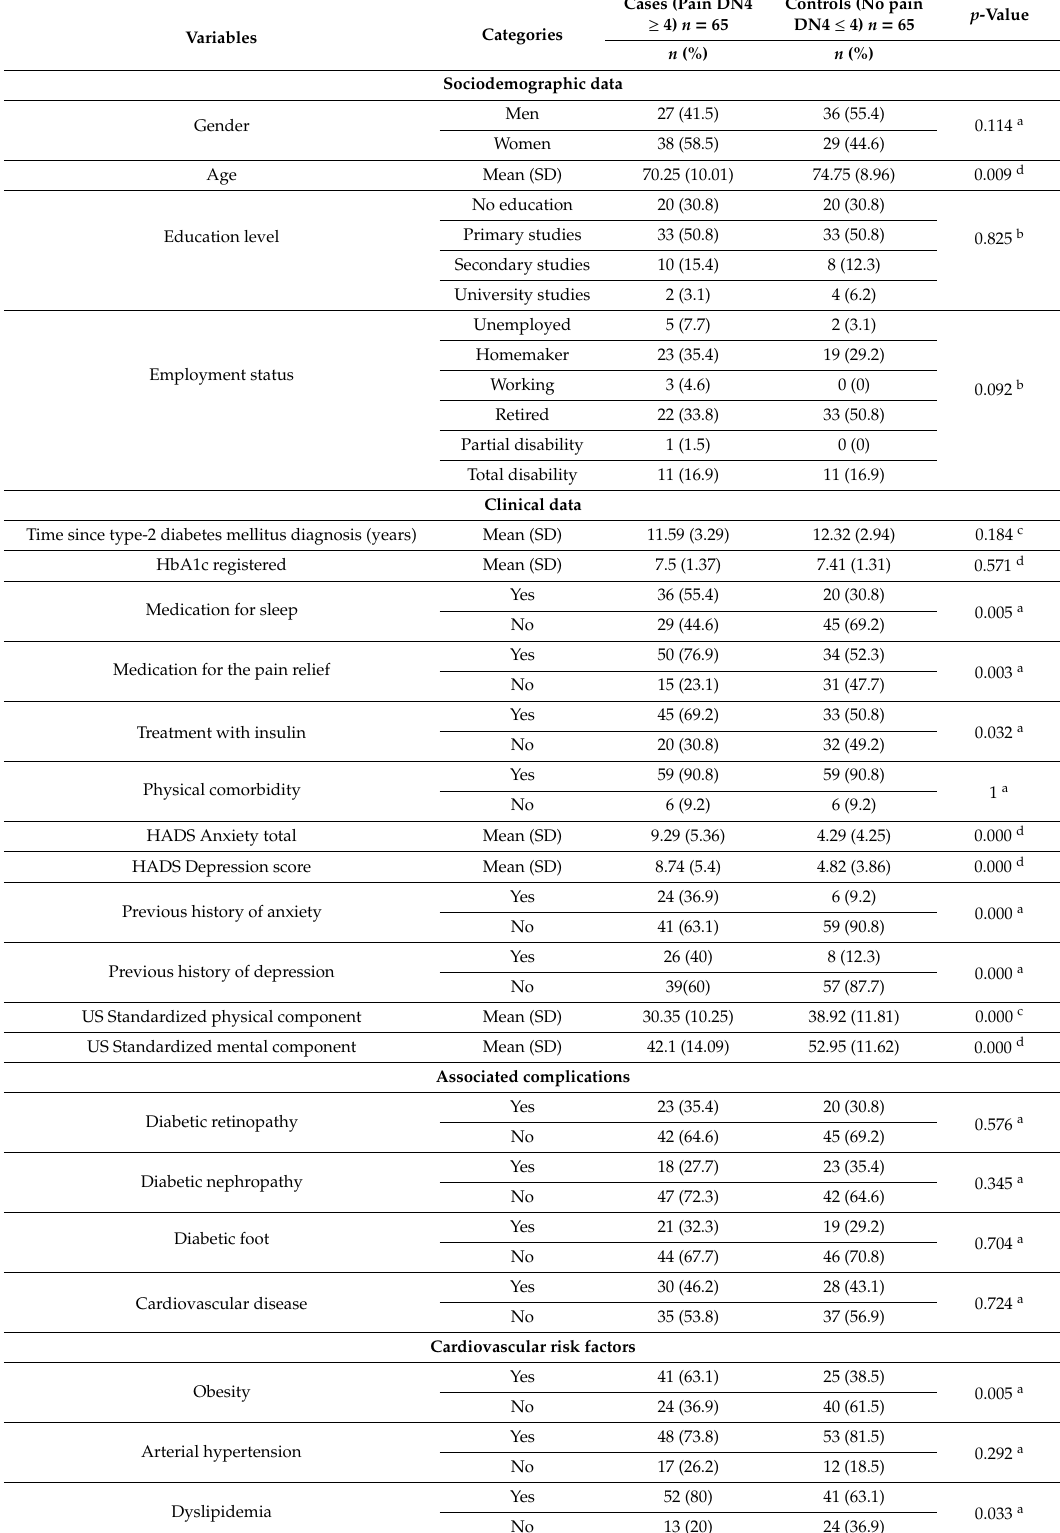
Table 1. Characteristics of the patients with and without